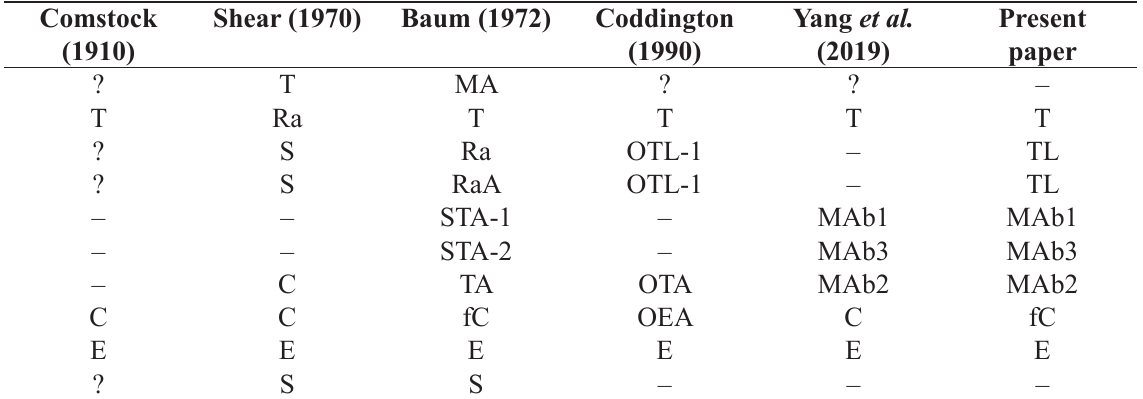
Table 1. Palpal terminology related to Oecobiidae in six